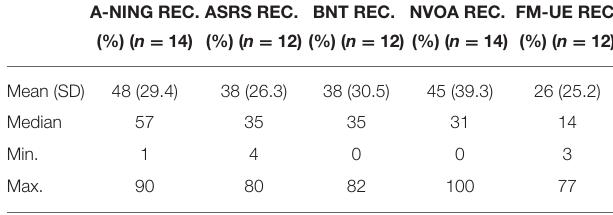
TABLE 4 | Correlation between assessments at A1 and A2 ( n = 15).